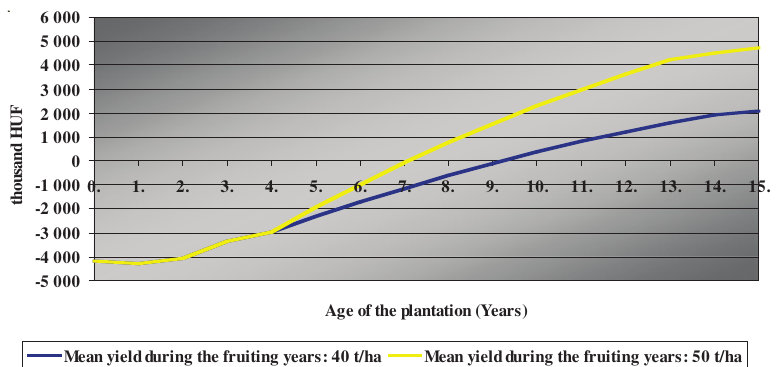
Figure 3. Economy and returns of plantations equipped with hail protecting nets and subsidy given for investment (net incomes on the present value are accumulated, expressed in thousand Ft/ha)